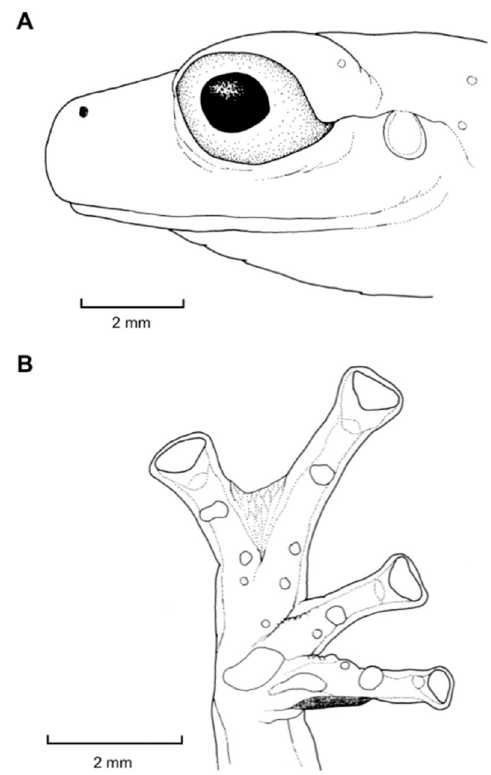
Figure 84. Espadarana audax , adult males. ( A ) Head in lateral view, KU 164503. ( B ) Hand in ventral view, KU 178018. Illustrations by Juan M. Guayasamin.